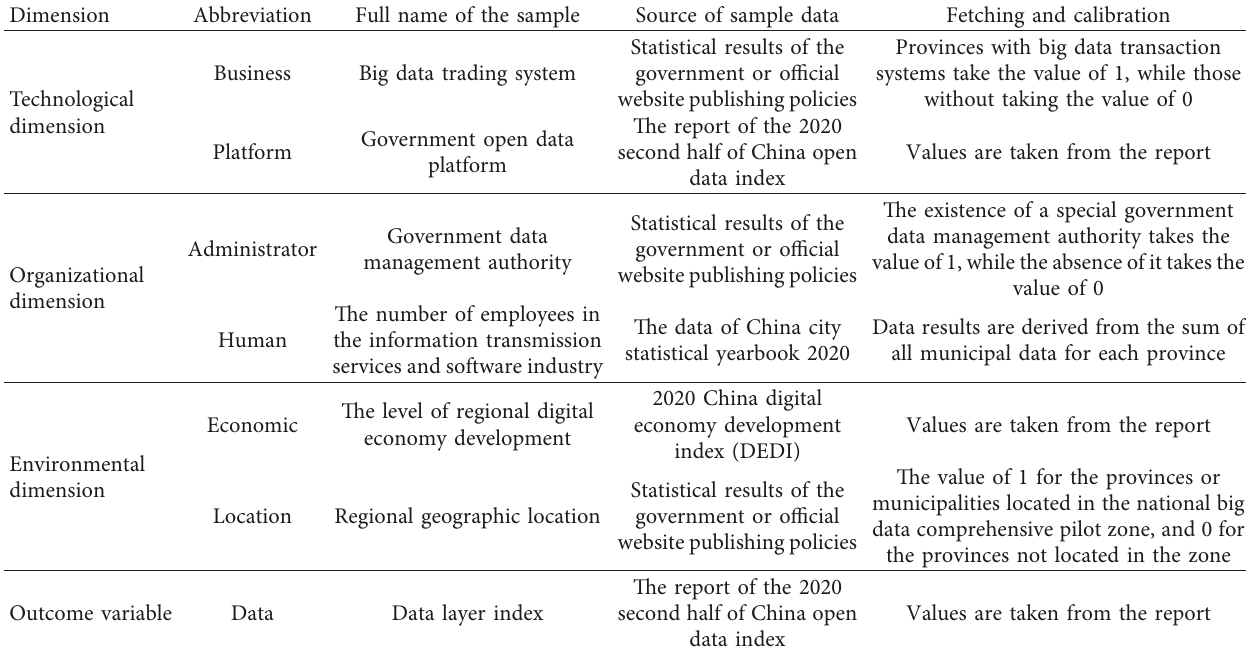
Table 1: Variables and their measurement